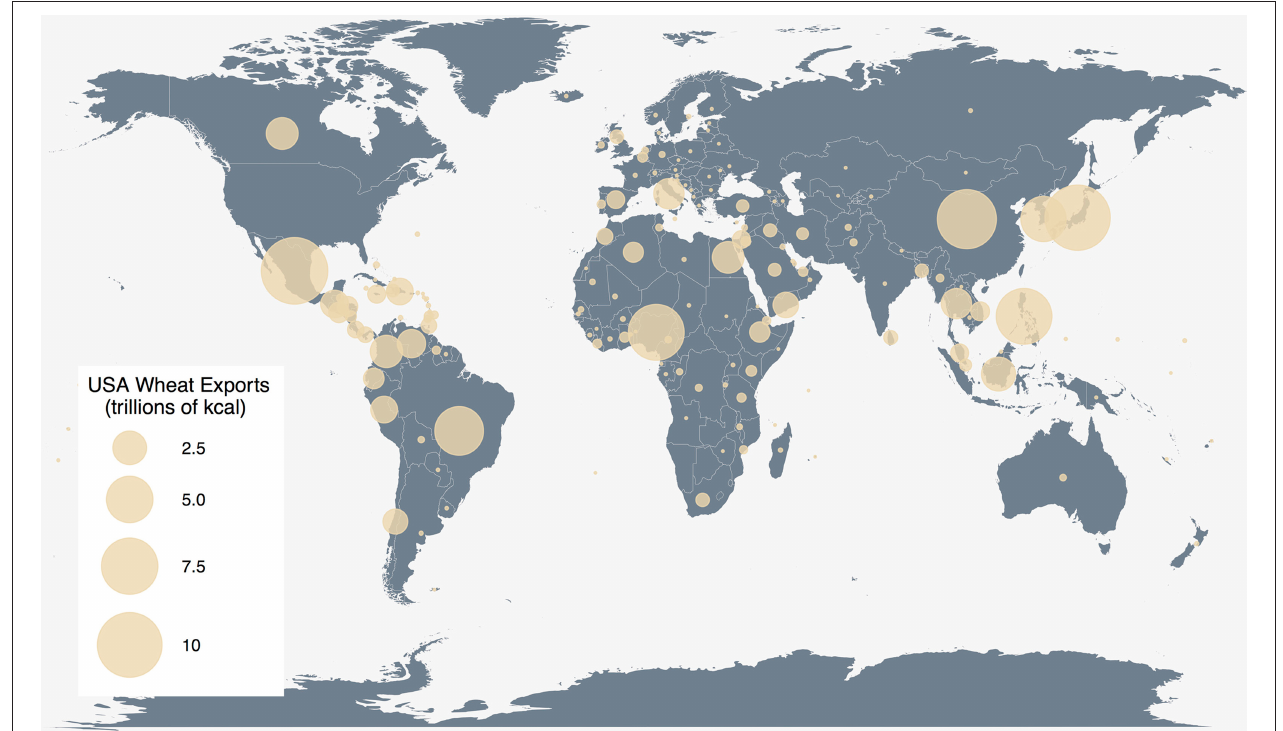
FIGURE 1 | US wheat export destinations in trillions of kcal based on 2012–2016 yearly average from FAOSTAT detailed trade matrix.